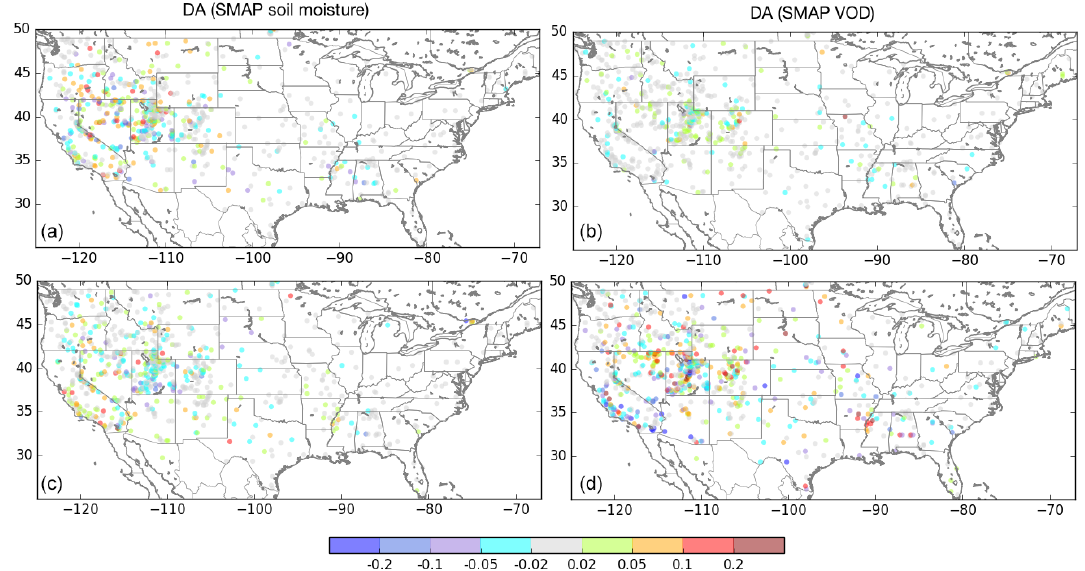
Figure 8. Differences in anomaly R values for surface soil moisture (a, b) and root zone soil moisture (c, d) from the assimilation of soil moisture (a, c) and VOD (b, d) , relative to the OL integration. The warm and cool colors indicate improvements and degradations from DA. The gray shading indicates locations where the anomaly R differences are not statistically significant.